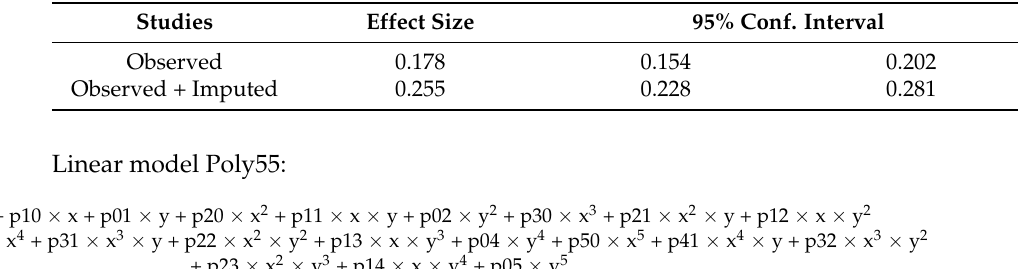
Table A3. Nonparametric trim-and-fill analysis for publication